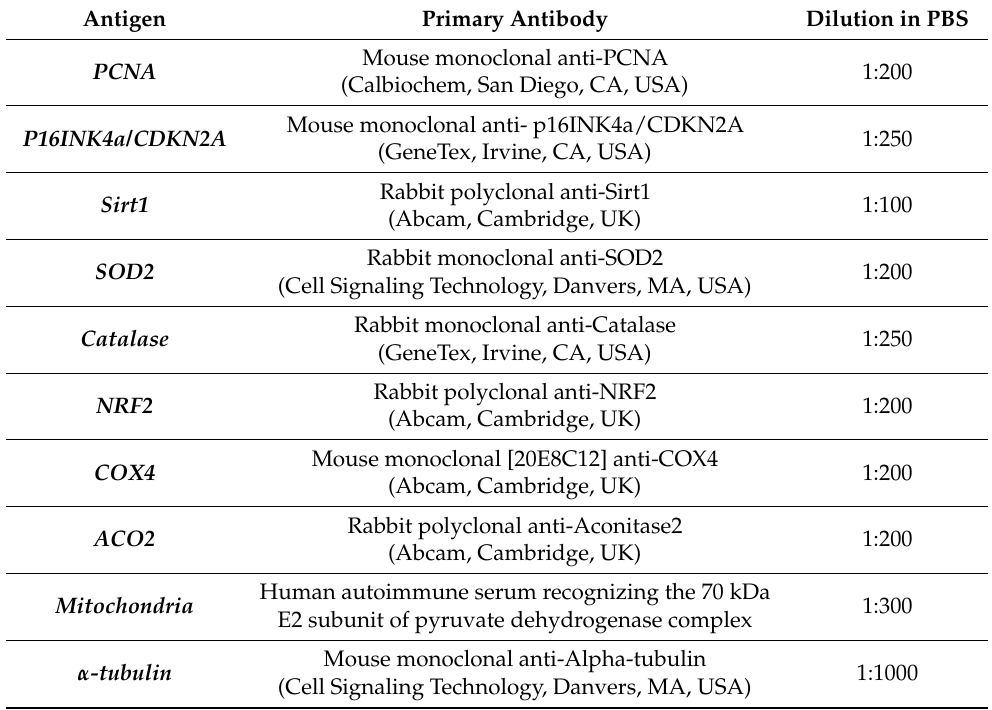
Table 2. Primary antibodies used for immunofluorescence